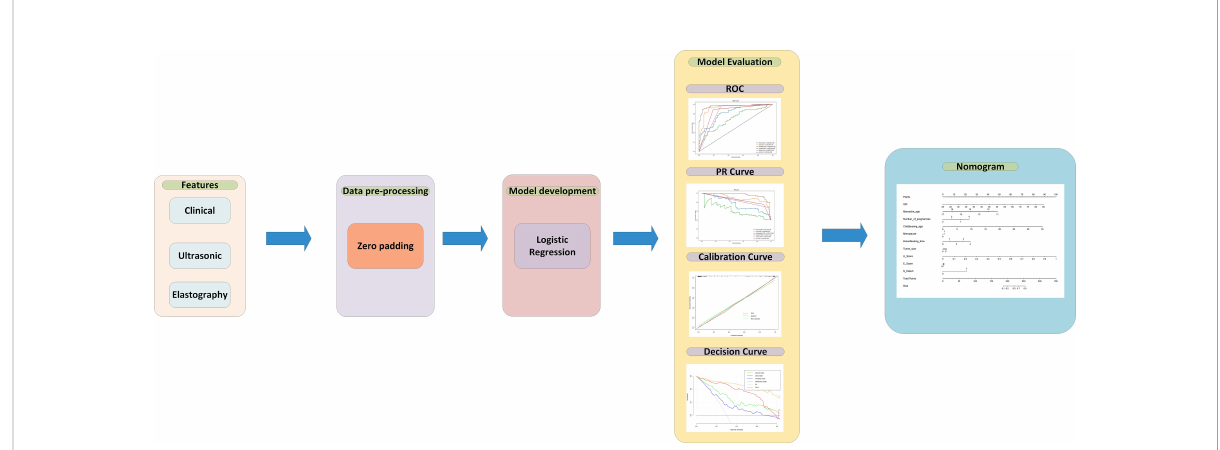
FIGURE 1 Schematic representation of the study fl ow. PR curve represent precision-recall